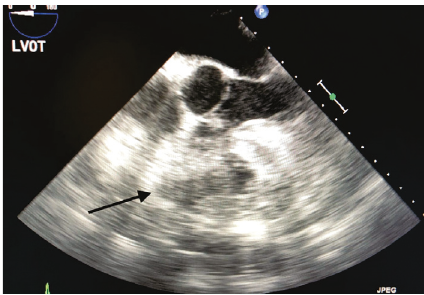
Figure 2: Transesophageal echocardiogram with ME 4CH view showing poor endocardial definition of the right ventricle and the thrombus.